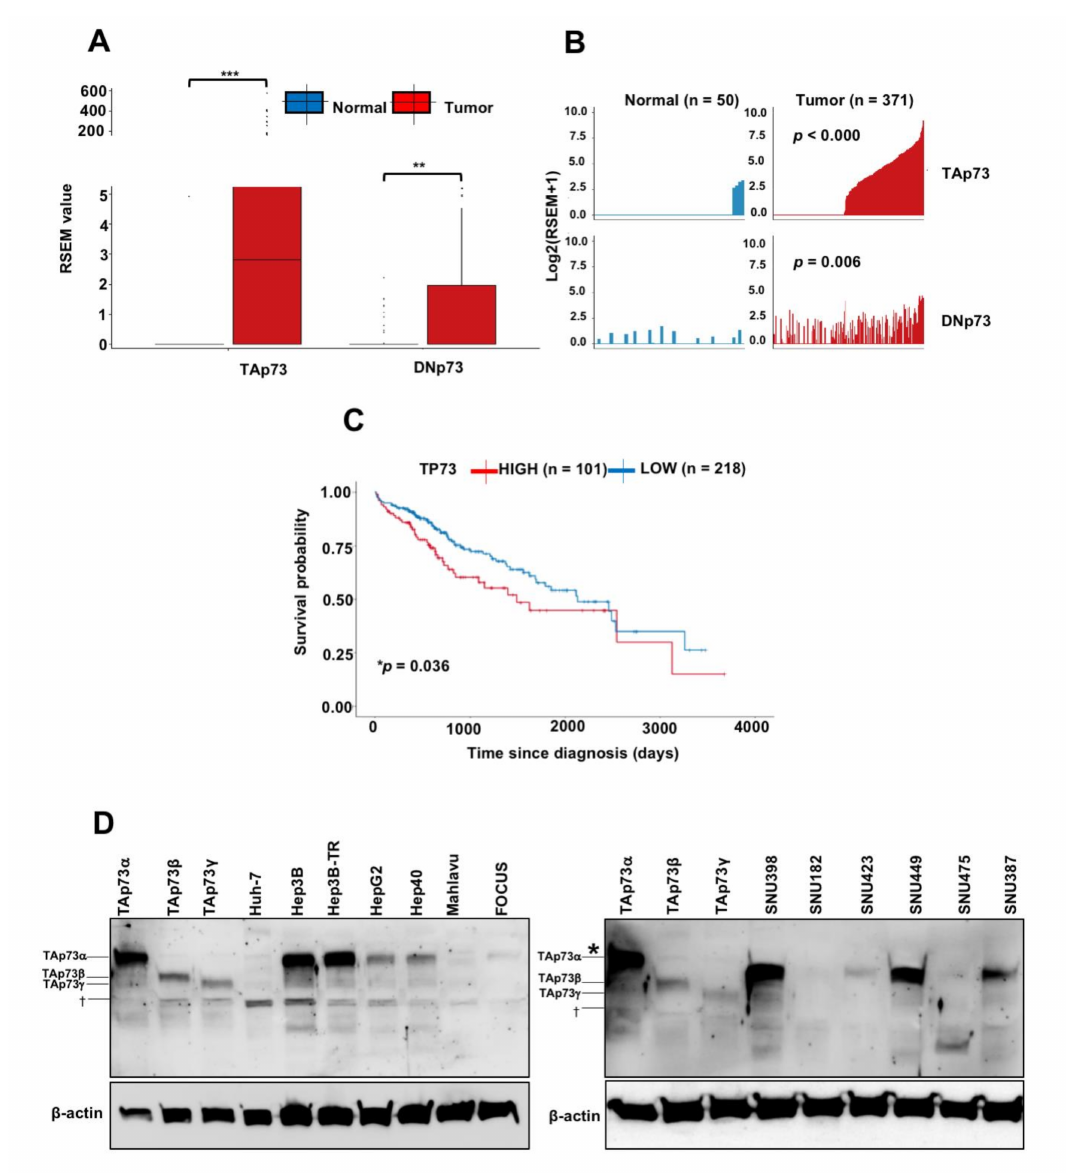
Figure 1. Strongly induced expression of TAp73 isoforms in hepatocellular carcinoma and poor survival of patients with a high p73 expression. ( A ) Box plots of p73 isoforms (TAp73 versus DNp73 isoforms) expression in non-tumor liver (normal; n = 50) and hepatocellular carcinoma (tumor; n = 371) were collected from the TSVdb database. *** p < 0.001 and ** p = 0.006 for significant differences between normal and tumor samples. ( B ) Bar plots of TAp73 and DNp73 isoforms distribution in normal and tumor samples. TAp73: Tumor %53.1 (n = 197/371)—Normal %8.0 (n = 4/50); DNp73: Tumor %37.4 (n = 139/371)—Normal %24.0 (n = 12/50) ( C ) Survival curves of liver cancer patients as a p73 high expression (n = 101), versus p73 low expression (n = 218). * p < 0.05. ( D ) p73 isoform expression in HCC cell lines was examined by western blot using a primary antibody against the full-length p73, which detects both TAp73 and DNp73 isoforms [27] and β -actin was used as a loading control (n = 2). p73 isoforms endogenously expressed in HCC cell lines were identified by comparing their relative migrations in the SDS-PAGE system in comparison with ectopically expressed TAp73 α , TAp73 β and TAp73 γ isoforms in Huh-7 cells using mammalian expression vectors. † Non-specific signals. * The apperant shift observed here is due to a problem of gel